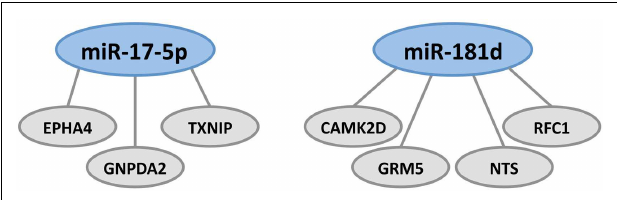
FIGURE 3 | Formaldehyde-responsive miRNAs predicted to modulate MAM-associated genes in the brains of Mgmt − / − mice. These include miR-17-5p and miR-181d, which regulate genes involved in tumor suppression, DNA repair, amyloid deposition, and glutamatergic and dopaminergic neurotransmission. MiR-17-5p regulates the expression of EPHA4 , GNPDA2 , and TXNIP .There is a large brain-related literature on the gene encoding ephrin type-A receptor 4 ( EPHA4 ) which, in the hippocampus, is located in the neuropil layers of CA1, CA3, and dentate gyrus. EPHA4 is involved in axonal development, maturation, targeting, and synapse formation (Tremblay et al., 2007; Clifford et al., 2011). Inhibition of EPHA4 signaling reduces apoptosis in hippocampal CA1 neurons and is involved in the γ -secretase pathway, which processes APP to the extracellular amyloid deposits that characterize AD, ALS-PDC, and other tauopathies (Inoue et al., 2009). EphA4 and EphB2 receptors were reduced in the hippocampus before the development of impaired object recognition and spatial memory in an AD mouse model of cognitive decline that overexpresses human APP protein (Simón et al., 2009). Literature on the gene coding for glucosamine-6-phosphate deaminase 2 (2-amino-2-deoxy-d-glucose 6-phosphate; GNPDA2 ) is primarily related to obesity; the gene is downregulated in the hypothalamus in rats on a high fat diet (Gutierrez-Aguilar et al., 2012).The gene encoding thioredoxin-interacting protein ( TXNIP ) is a molecular nutrient sensor important in the regulation of energy metabolism and also involved in obesity (Blouet and Schwartz, 2011). Blockade of the NMDA receptor upregulates TXNIPin vivo and in vitro , where it binds thioredoxin and promotes vulnerability to oxidative damage (Martel et al., 2009). Transcriptional expression of both TXNIP and TP53 is upregulated in Cockayne syndrome, a human premature aging and dementing disorder (without amyloid deposition) associated with neurological and developmental abnormalities, and caused by mutations mainly in the CS group B gene ( ERCC6, excision repair cross-complementing rodent repair deficiency 6; de Sousa Andrade et al., 2012). MiR-181d regulates the expression of CAMK2D , GRM5 , NTS , and RFC1 .The gene coding for DNA replication factor-1 ( RFC1 ) is involved in DNA replication and repair,